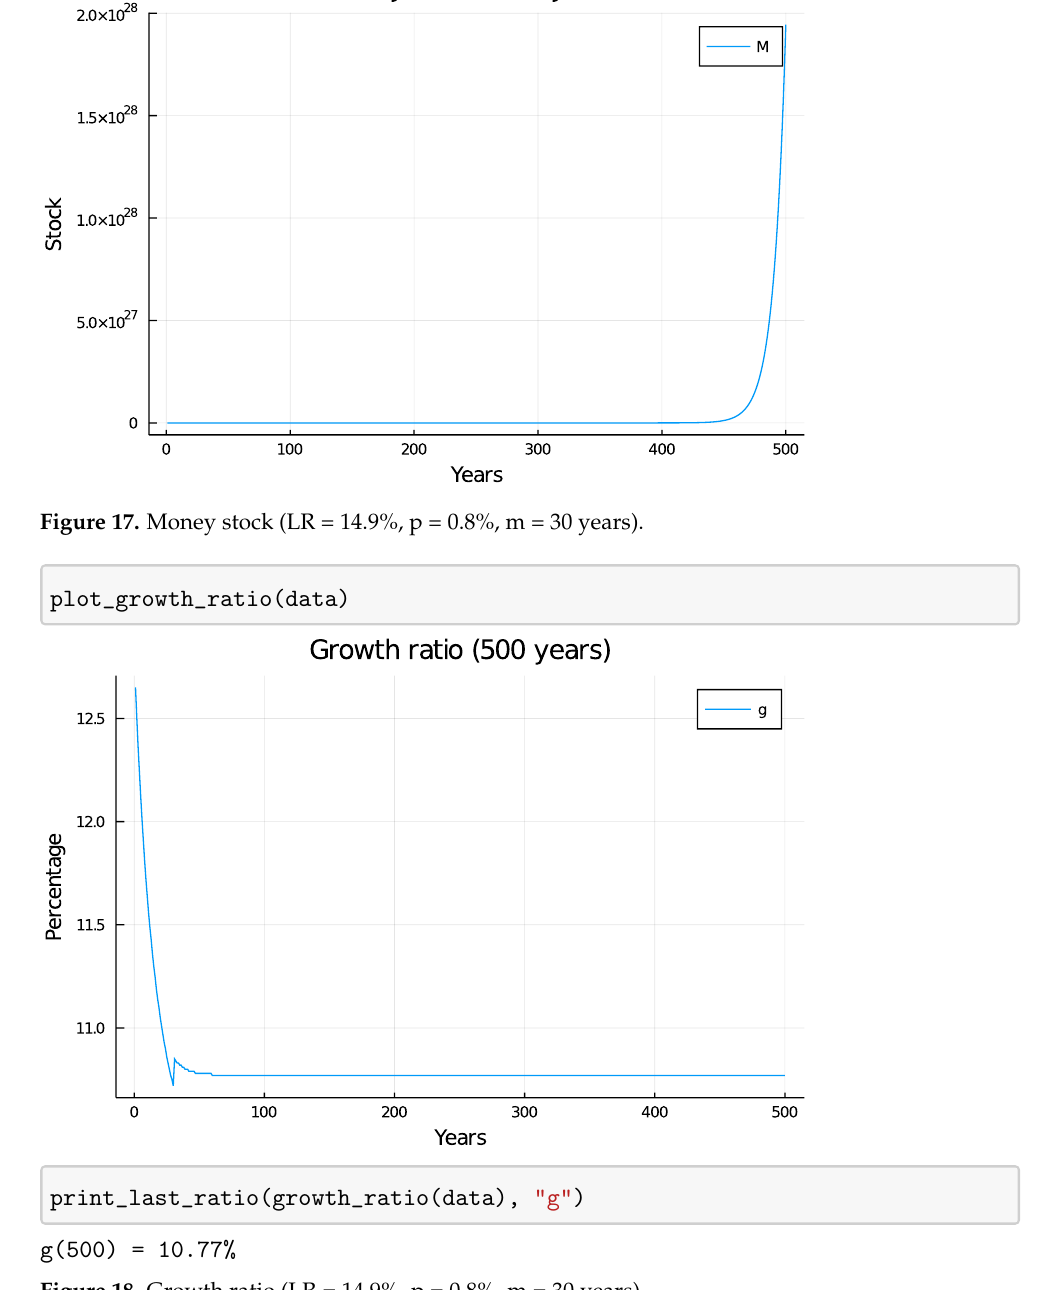
Figure 18. Growth ratio (LR = 14.9%, p = 0.8%, m = 30